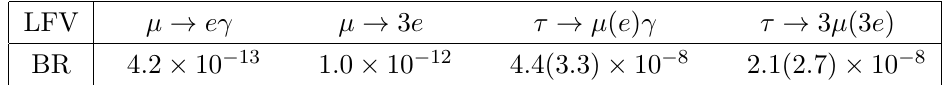
Table 2 . Current experimental upper limits of the selected LFV